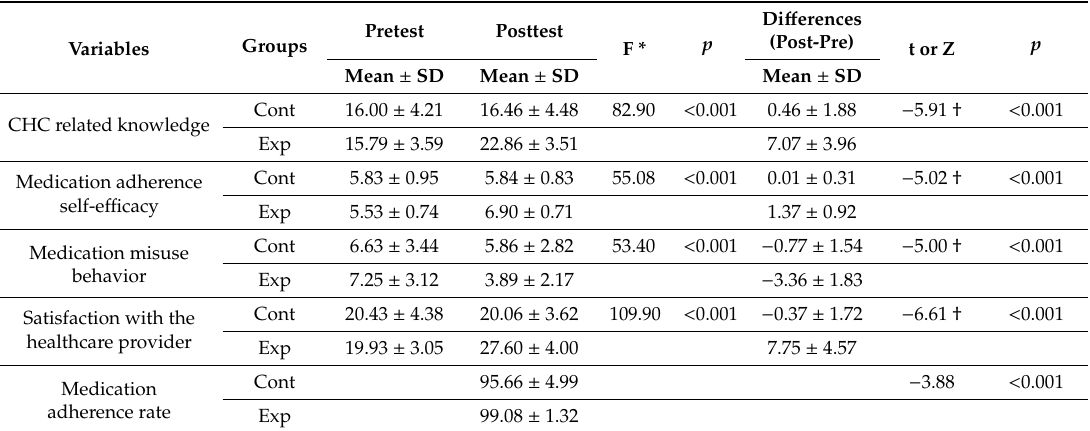
Table 4. E ff ectiveness of the